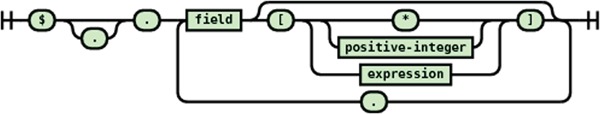
JSONPath syntax for the source document.